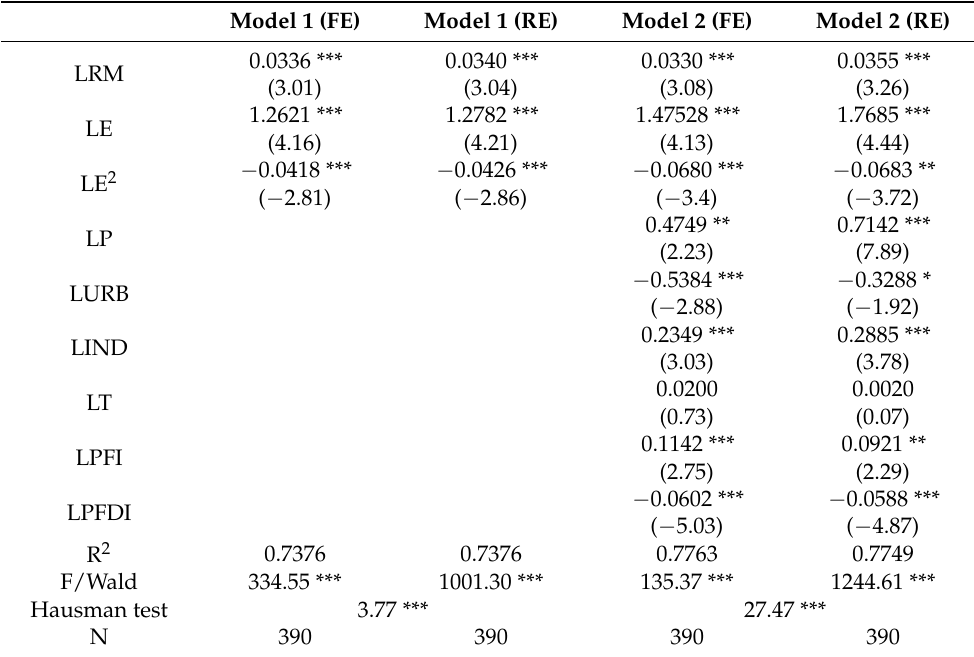
Table 4. The impacts of LRM on carbon emissions at the national